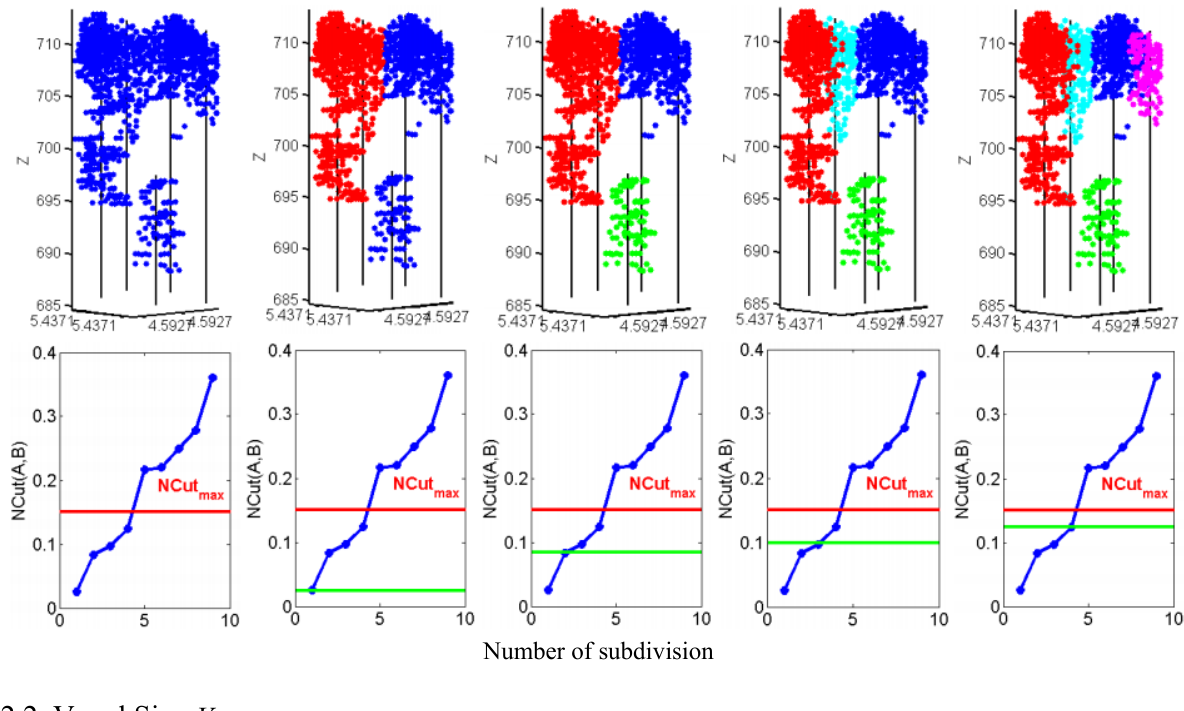
Figure 2. Recursive normalized cut for a five-tree example by progressively increasing the NCut value (green line) Thres